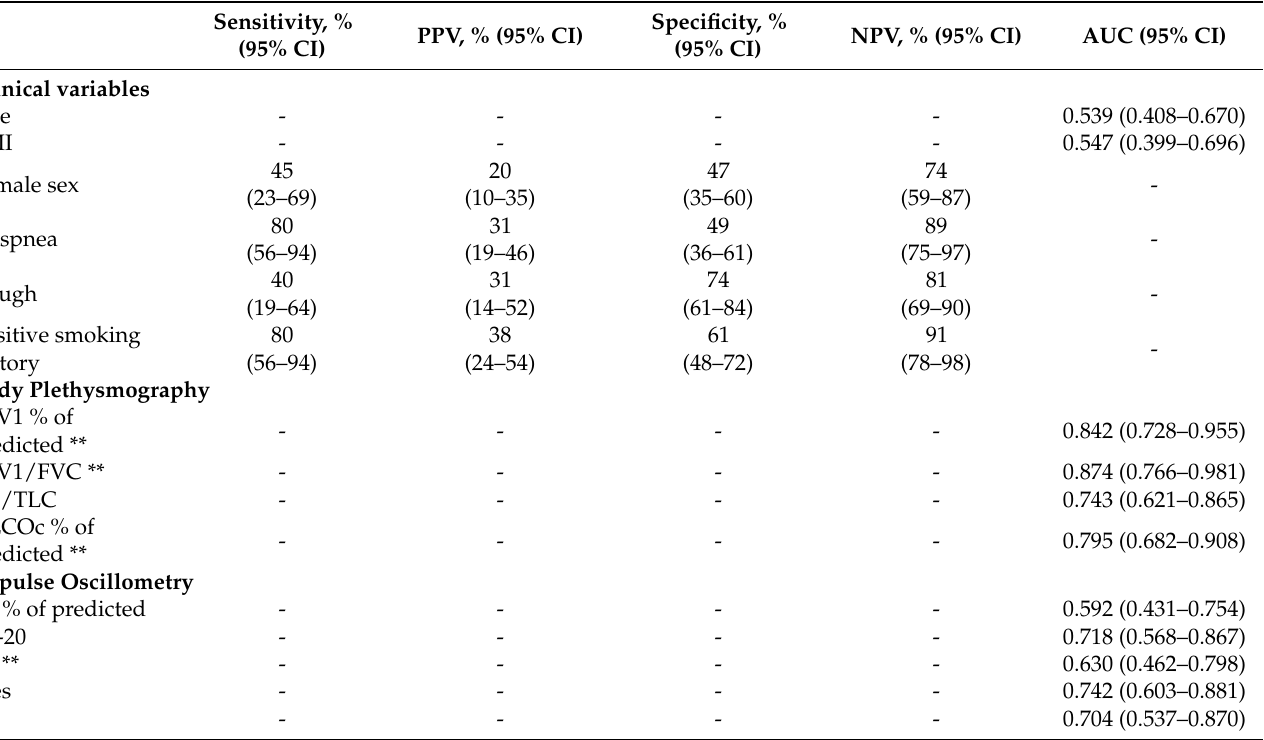
Table 2. Diagnostic accuracy of each individual variable considered for logistic regression compared to reference standard outcome